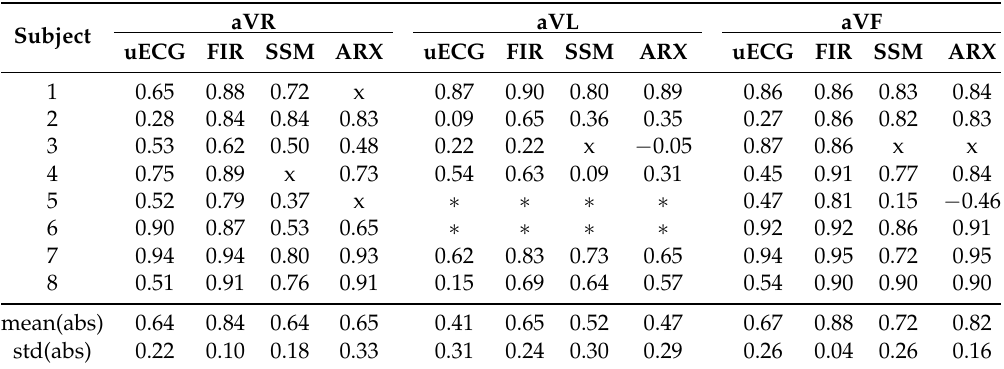
Table 2. Correlation coefficient of estimation on validation data, compared to